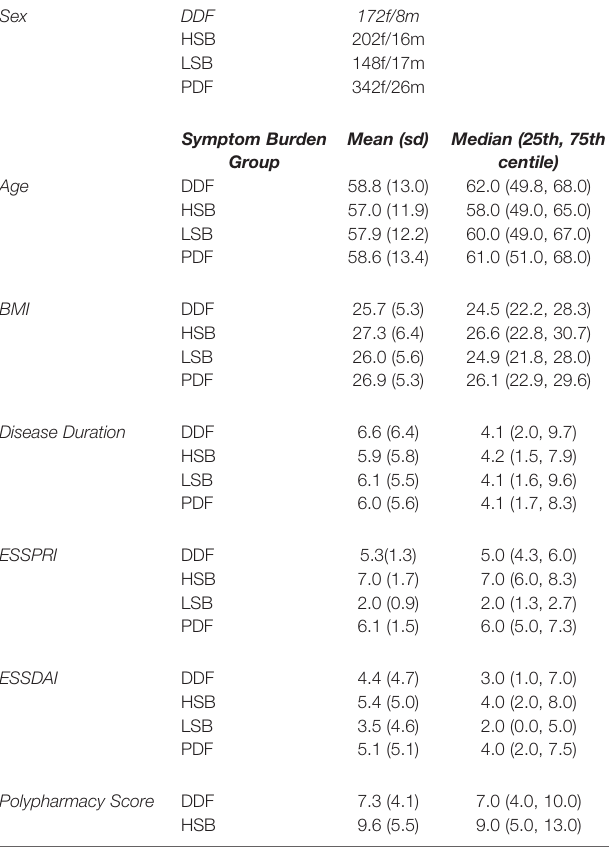
TABLE 1.2 | Cohort characteristics: a summary of key demographic and clinical data for four symptom burden groups of PSS participants at the time of